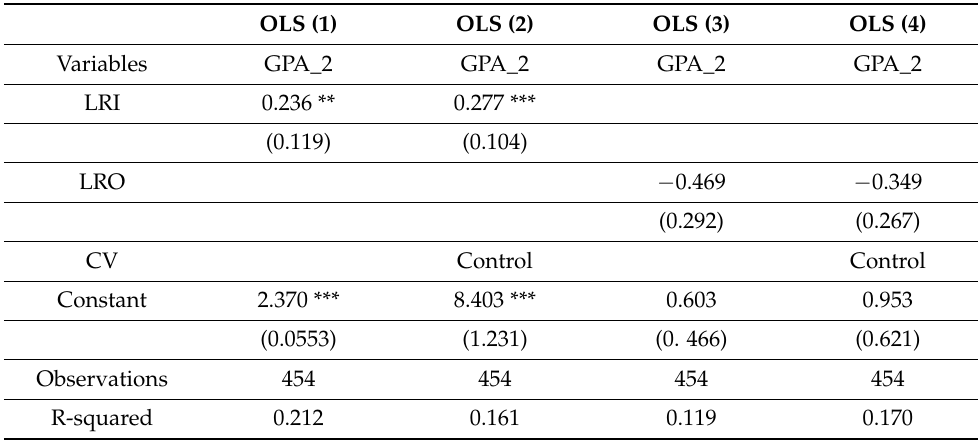
Table 5. Robustness test results of the regression of LRI and